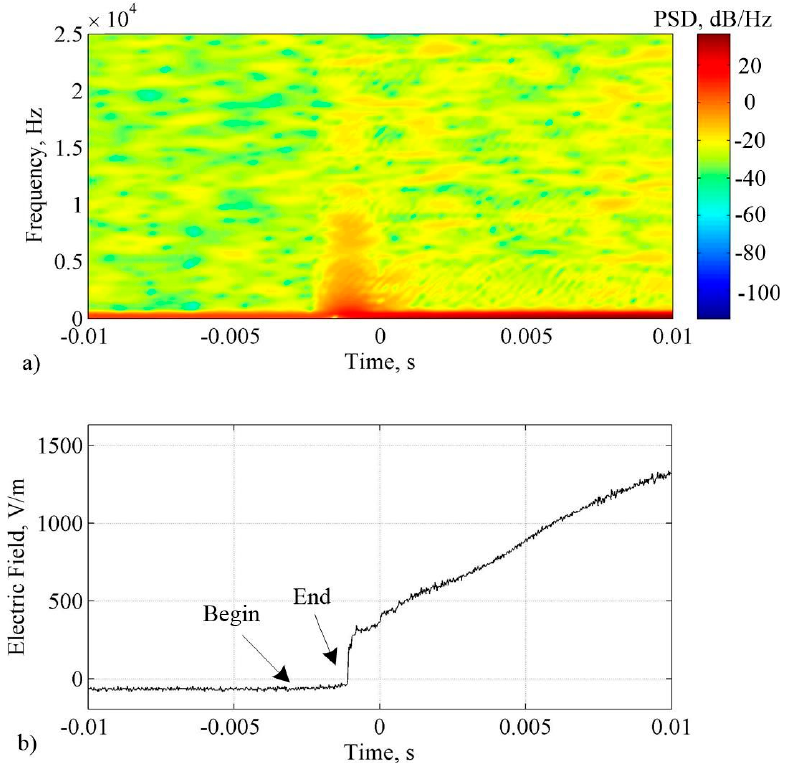
Figure 6. Description is the same as in Figure 4, except for the parameters of Case #7 given in Table 1.